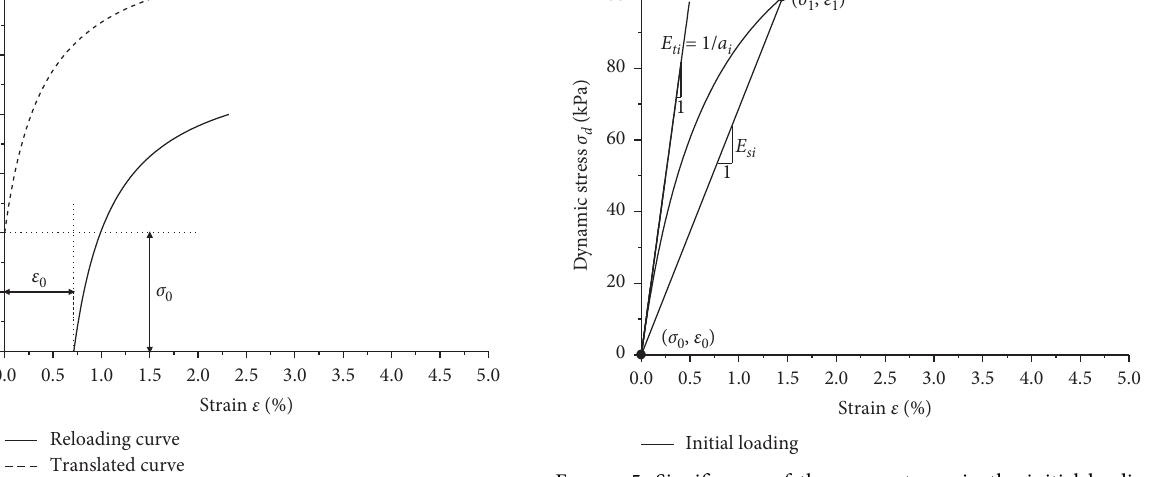
Figure 4: Stress-strain and translated stress-strain curves in the reloading